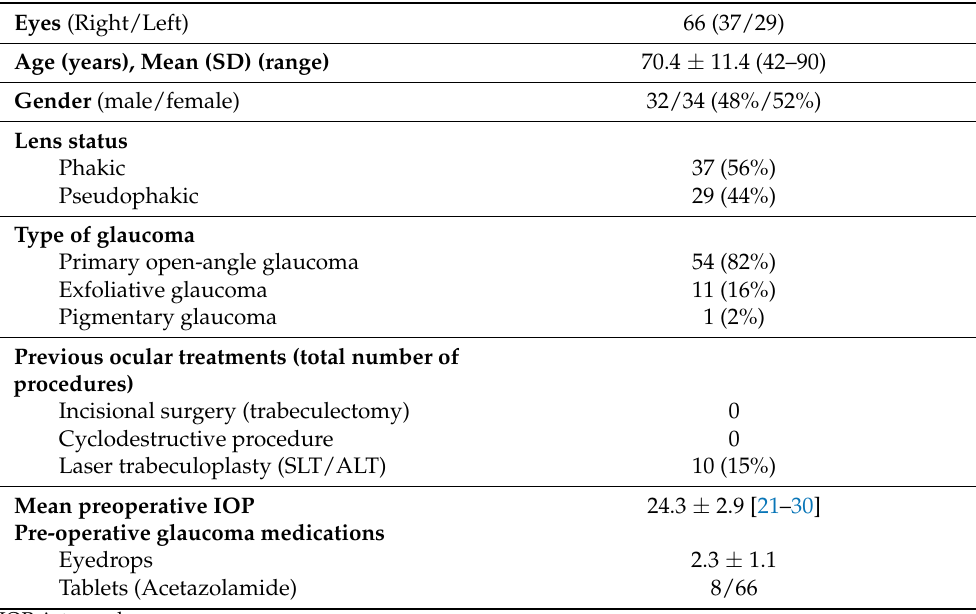
Table 1. Baseline demographic characteristics of eyes undergoing Ultrasound Cyclo Plasty ( n = 66). Eyes (Right/Left) 66 (37/29) Age (years), Mean (SD)